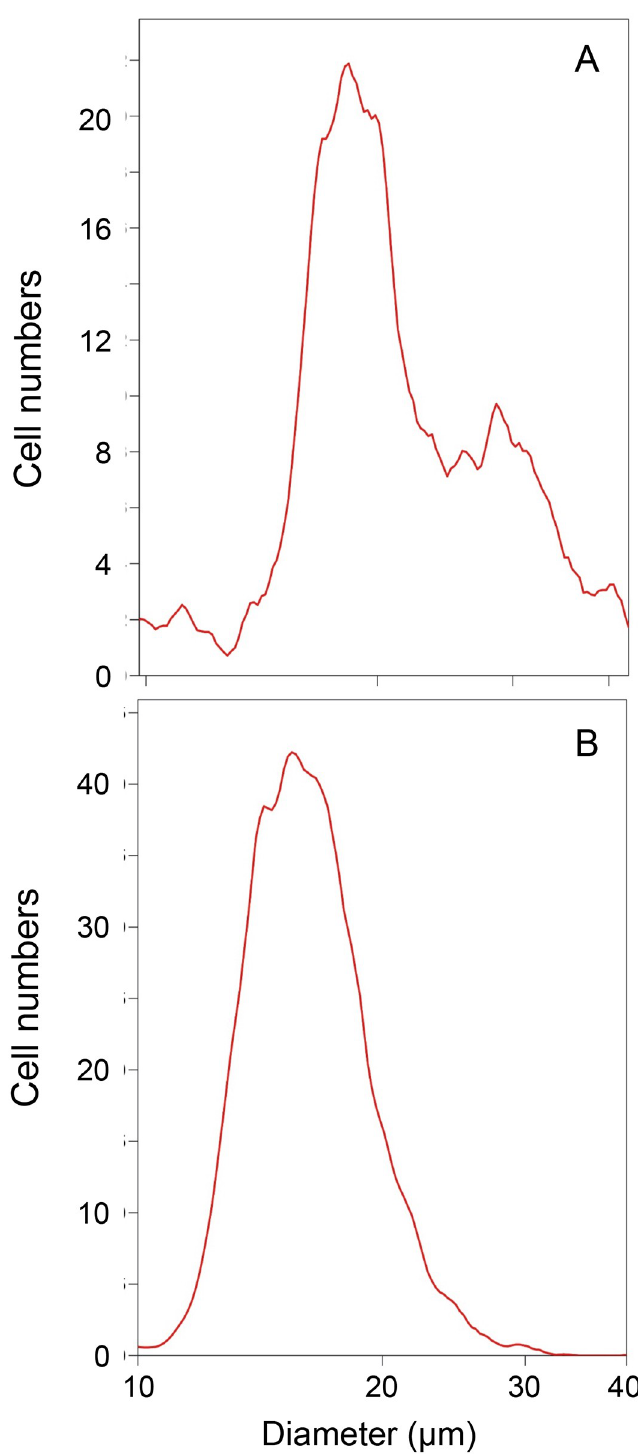
Fig 2. Cell size distribution. (A) Passage 3 white sturgeon epidermal cells confluent for a week and (B) confluent human dermal fibroblasts were trypsinized, suspended in saline and analyzed electronically using a Multisizer 3 Coulter counter adapted for measurement of cell